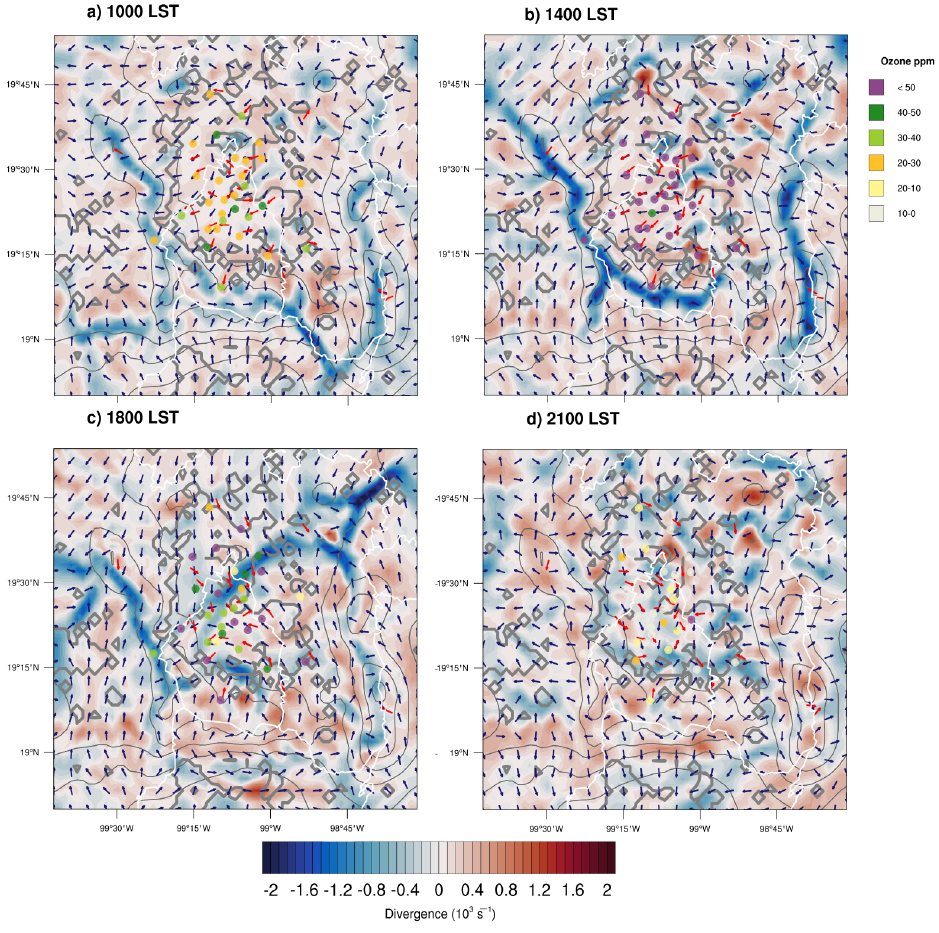
Figure 5. Observed (red vectors) and modeled (black vectors) 10 m horizontal wind and correspond- ing divergence fields (10 3 s − 1 ) at ( a ) 1000 LST, ( b ) 1400 LST, ( c ) 1800 LST, and ( d ) 2100 LST, for 10 February 2017. Superposed are the values of ozone concentration from 30 active SEDEMA air quality stations. Note that the norm of wind vectors is set to a unitless value of